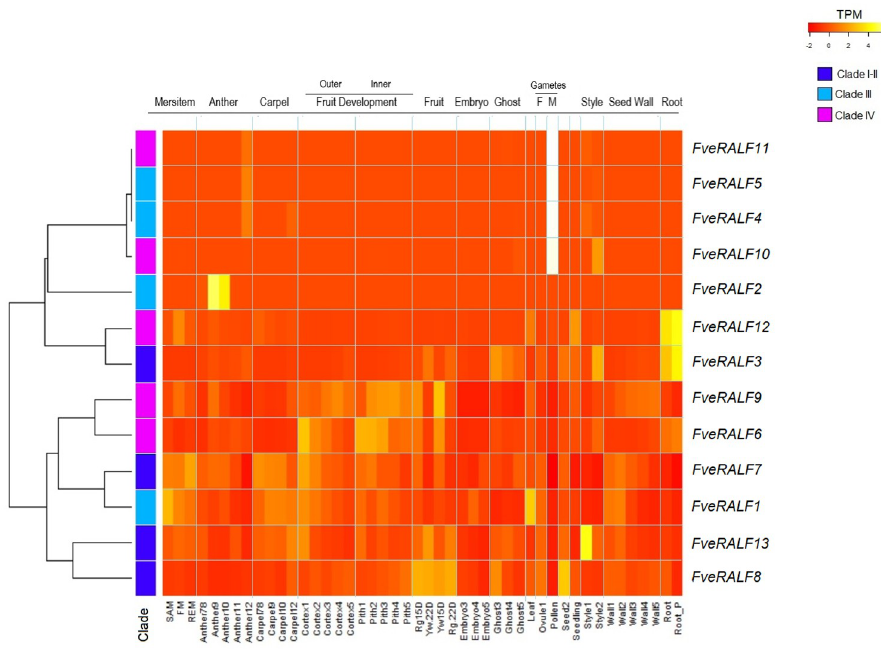
Fig 2. Detection of RALF transcripts in F . vesca . The heatmap reflects the expression profile (as Transcription per Kilobase Million (TPM)) of FveRALF members (rows) in different tissues and developmental stages (column) of F . vesca . Labels at the bottom specify the tissues and the stages, whereas labels at the top group tissues and stages for organs. Dendrogram on the left shows rows relationship according to similar expression profile. RALF members classification in clades are shown: in green clade I, in blue clade II, in light blue clade III and magenta clade IV. SAM (shoot apical meristem), FM (floral meristem), REM (receptacle meristem), Anther7-8 (identified by stomium development and appearance of a preliminary lobed structure), Anther9 (microspore mother cells start meiosis), Anther10 (microspores are loose in the locule after callose wall holding tetrads disaggregates), Anther11 (pollen mitotic division occurs), anther12 (no visible change in anther development), Carpel7/8 (round carpel primordial reach the receptacle apex), Carpel9 (bowling pin shaped carpel primordial), Carpel10 (carpel is dived in almost equal apical and basal part by a central constriction), Carpel11 (style is elongated and became twice in length than the ovary base), Carpel12 (carpels have music note shape and styles are separated from each other), Cortex1 and Pith1 (flower just opened), Cortex2 and Pith2 (at about 3 DPA, when pollination occurs), Cortex3 and Pith3 (at about 6 DPA), Cortex4 and Pith4 (at about 9 DPA), Cortex5 and Pith5 (at about 12 DPA), Rg15D and Rg22D (Red Ruegen receptacle tissue at 15 DPA and at 22 DPA), Yw15D and Yw22D (Yellow Wonder receptacle tissue at 15 DPA and at 22 DPA), Embryo3 and Ghost3 (embryo and seed without embryo inside at about 6 DPA characterized by heart shape), Embryo4 and Ghost4 (at about 9DPA, with immature cotyledons), Embryo5 and Ghost5 (ad about 12 DPA, mature embryo which fill up entire ovules), Leaf (young trifoliate leaves), Ovule1 and Pollen (collected from just open flower), Seed2 (complete achene from mature fruit), Seedling (complete seedling at 10 days post germination), Style1 (style and stigma from just open flowers), Style2 (style from flower at about 3 DPA), Wall1 (carpel wall from just open flower), Wall2 (carpel wall at about 3 DPA), Wall3 (carpel wall at about 6 DPA), Wall4 (carpel wall at about 9 DPA), Wall5 (carpel wall at about 12 DPA), Root (collected from 7 week old plants grown in aerated hydroponic culture) and Root_P (after 2 days of inoculation with Phytophthora cactorum